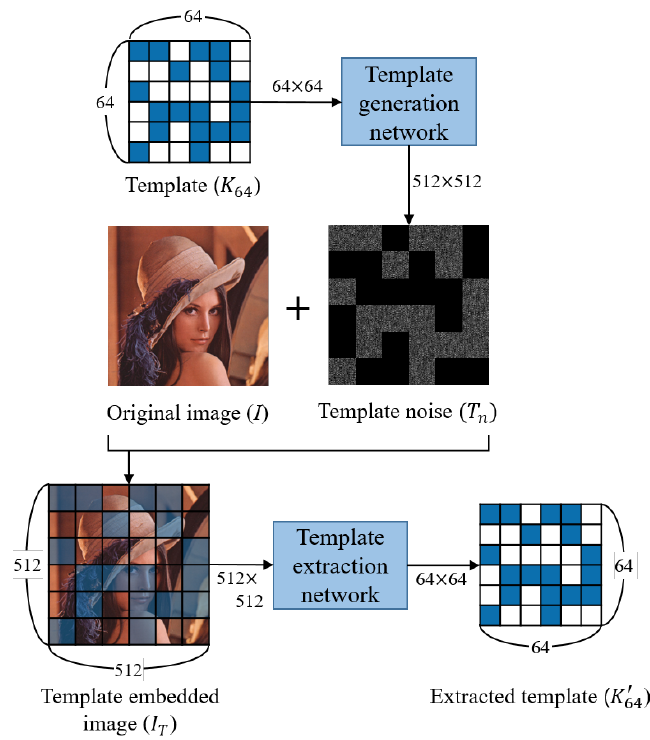
Figure 3. Template insertion and extraction overview. Networks are trained so that the extracted template K (cid:48) and the inserted template K 64 have the same 64